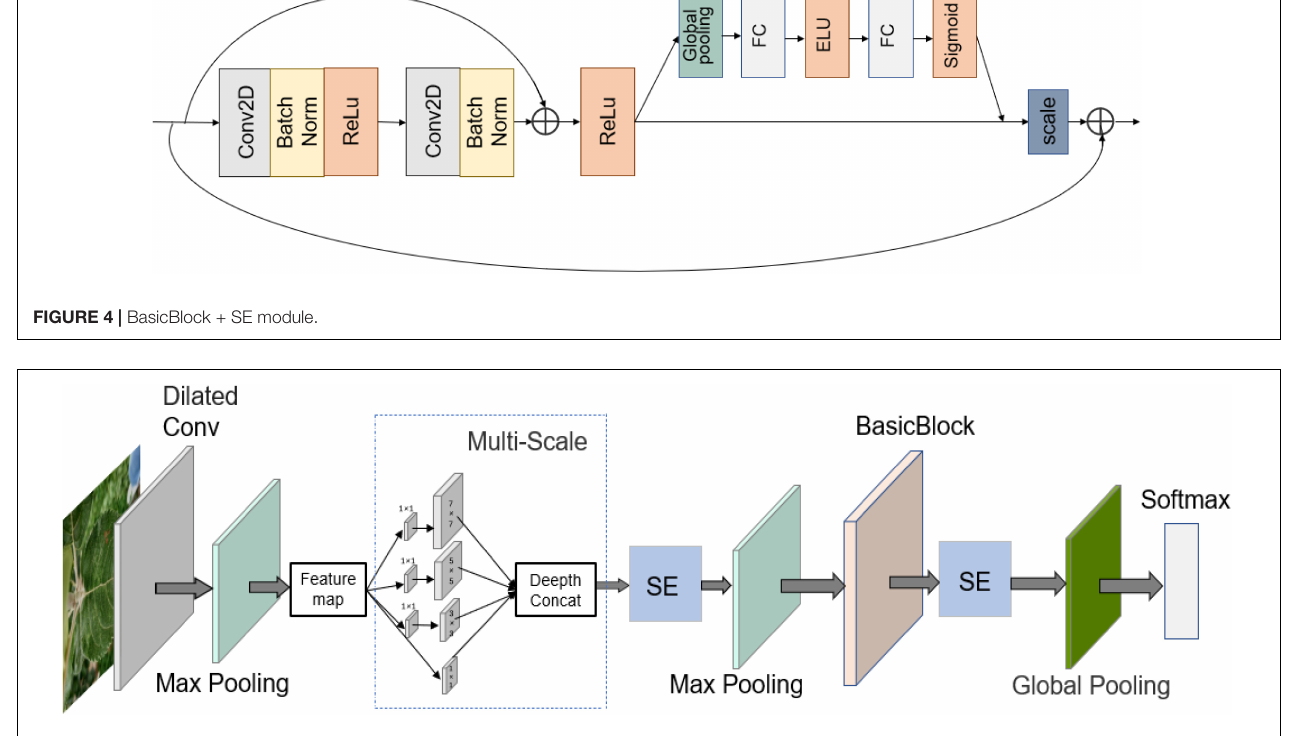
FIGURE 5 | Apple leaf disease identification